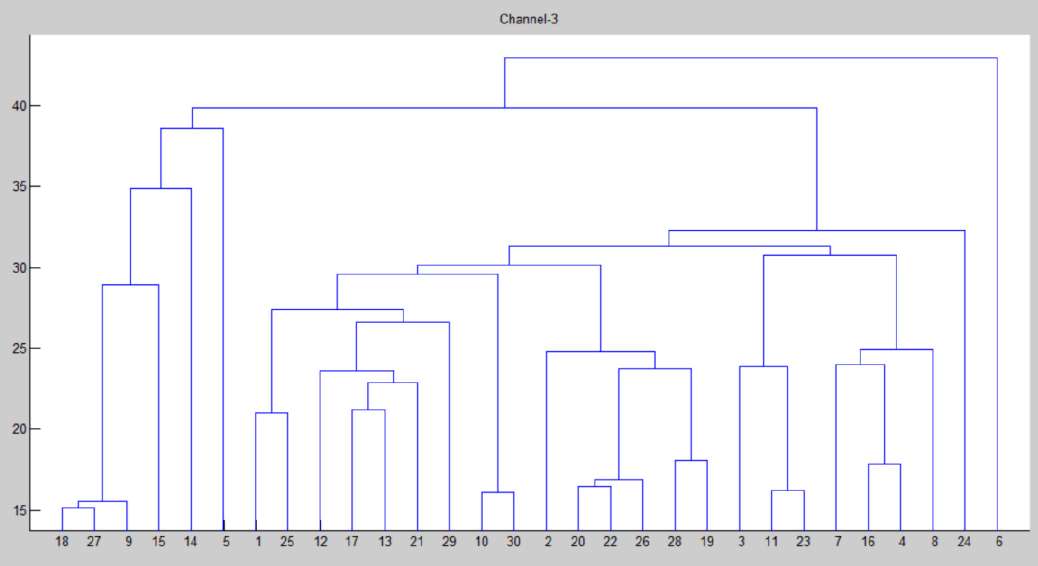
Figure 10. Channel 3 grouping.